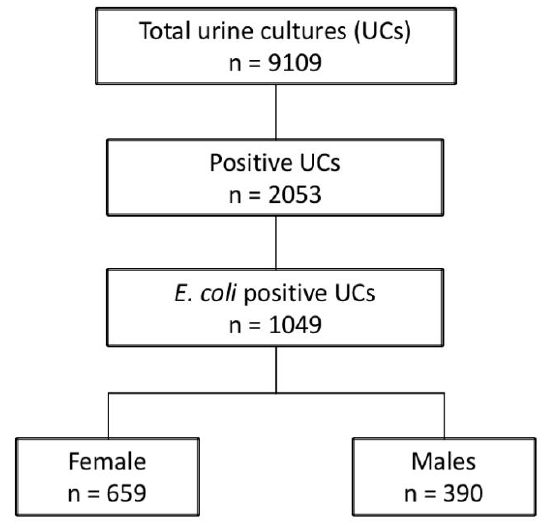
Figure 1. Patient flow chart.